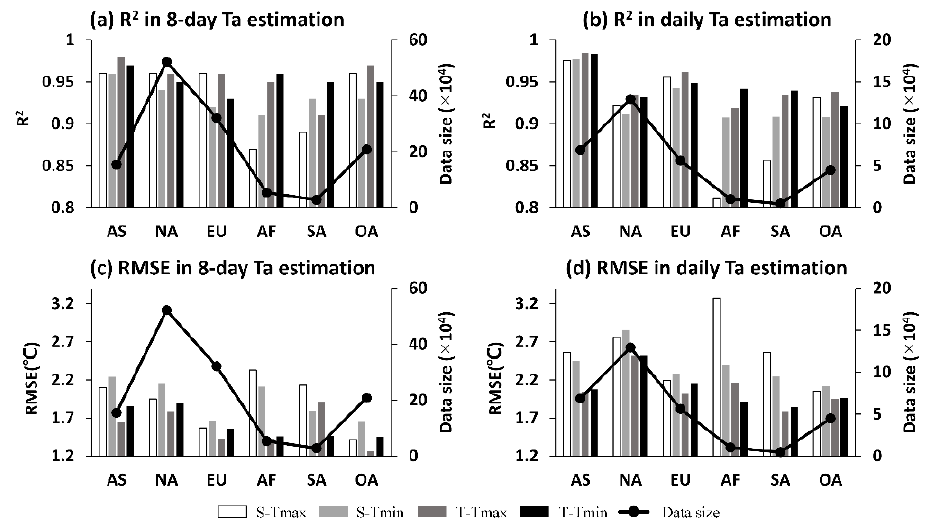
Figure 3. Estimation accuracy, i.e., R 2 and RMSE, of 8-day ( a , c ) and daily ( b , d ) Tmax and Tmin in both spatial and temporal experiments on a continental scale: Asia (AS), North America (NA), Europe (EU), Africa (AF), South America (SA), Oceania (OA).